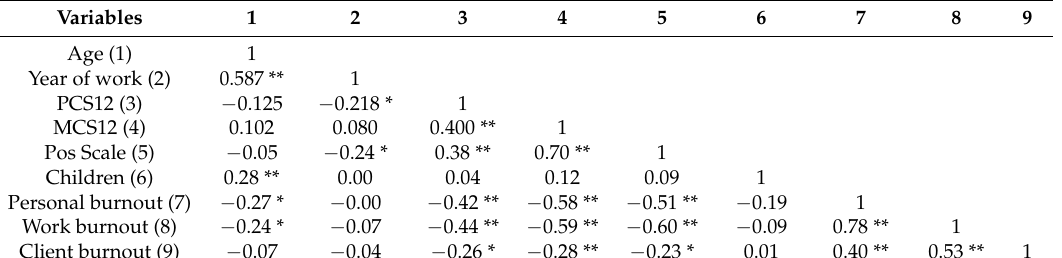
Table 4. Correlation